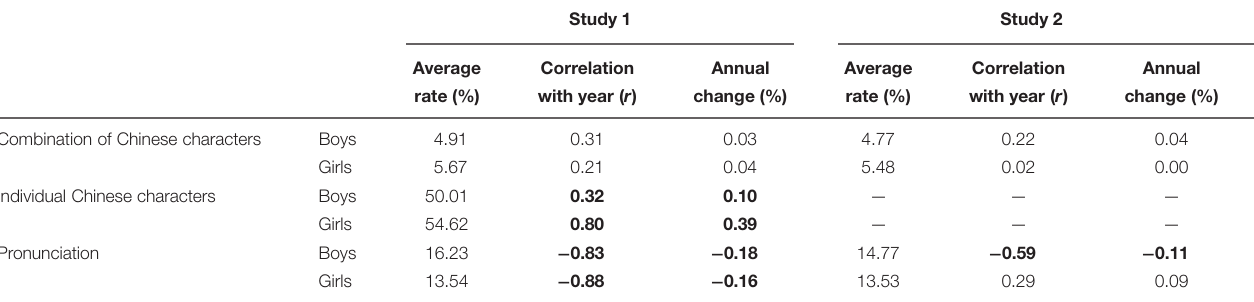
TABLE 2 | Average rates (%), correlations with year ( r ), and annual changes (%) of top 10 common names in Study 1 and 2.